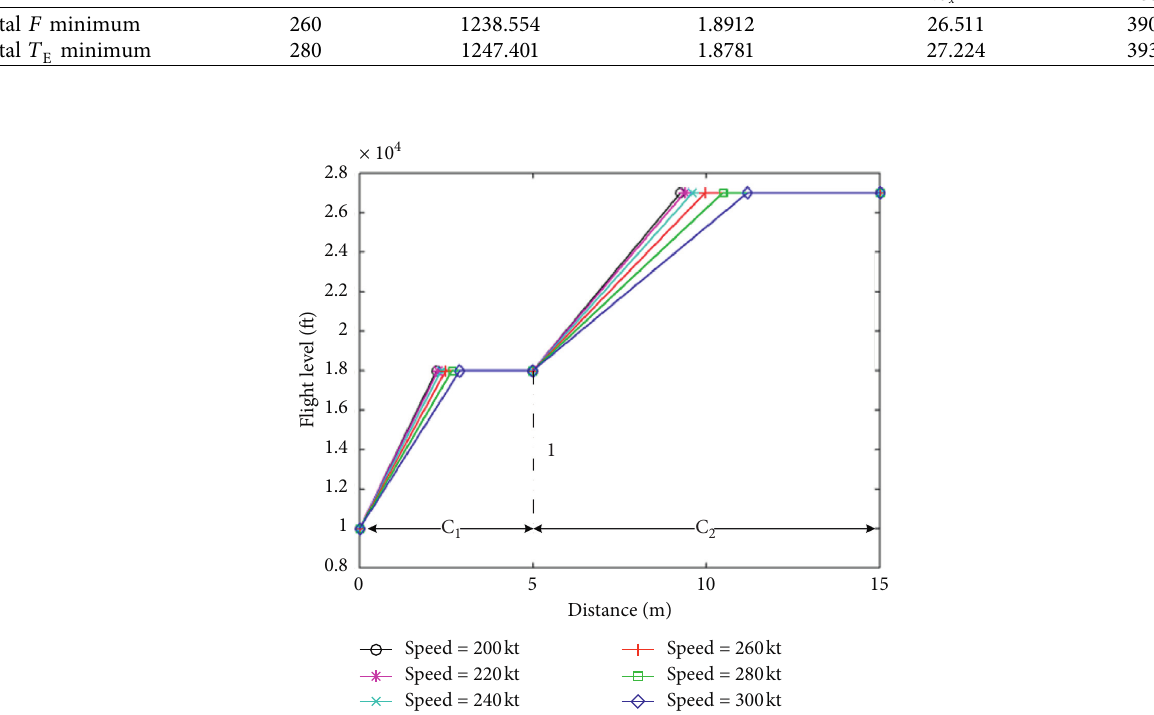
Figure 5: Flight trajectories corresponding to different flight speeds.